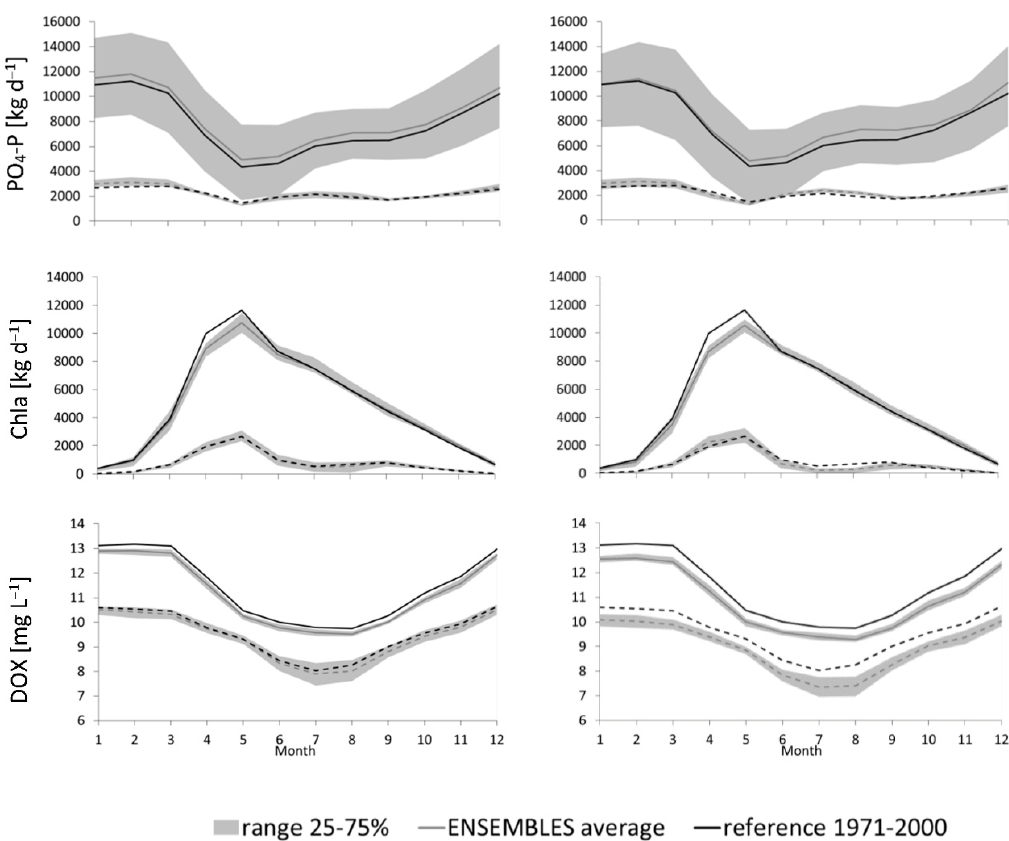
Figure 6. The long-term average monthly values of simulated discharge (Q), nutrient and chlorophyll a loads (NO 3 -N, NH 4 -N, PO 4 -P, Chla) and dissolved oxygen concentrations (DOX) with uncertainty ranges (25th/75th percentiles corresponding to 19 simulations) at the two Elbe gauges Neu Darchau ( full lines ) and Schöna ( dashed lines ) for the future periods 2021–2050 ( p1, a ) and 2071–2078 ( p2, b ) in comparison to the corresponding average values of the reference period 1971–2000 (p0).